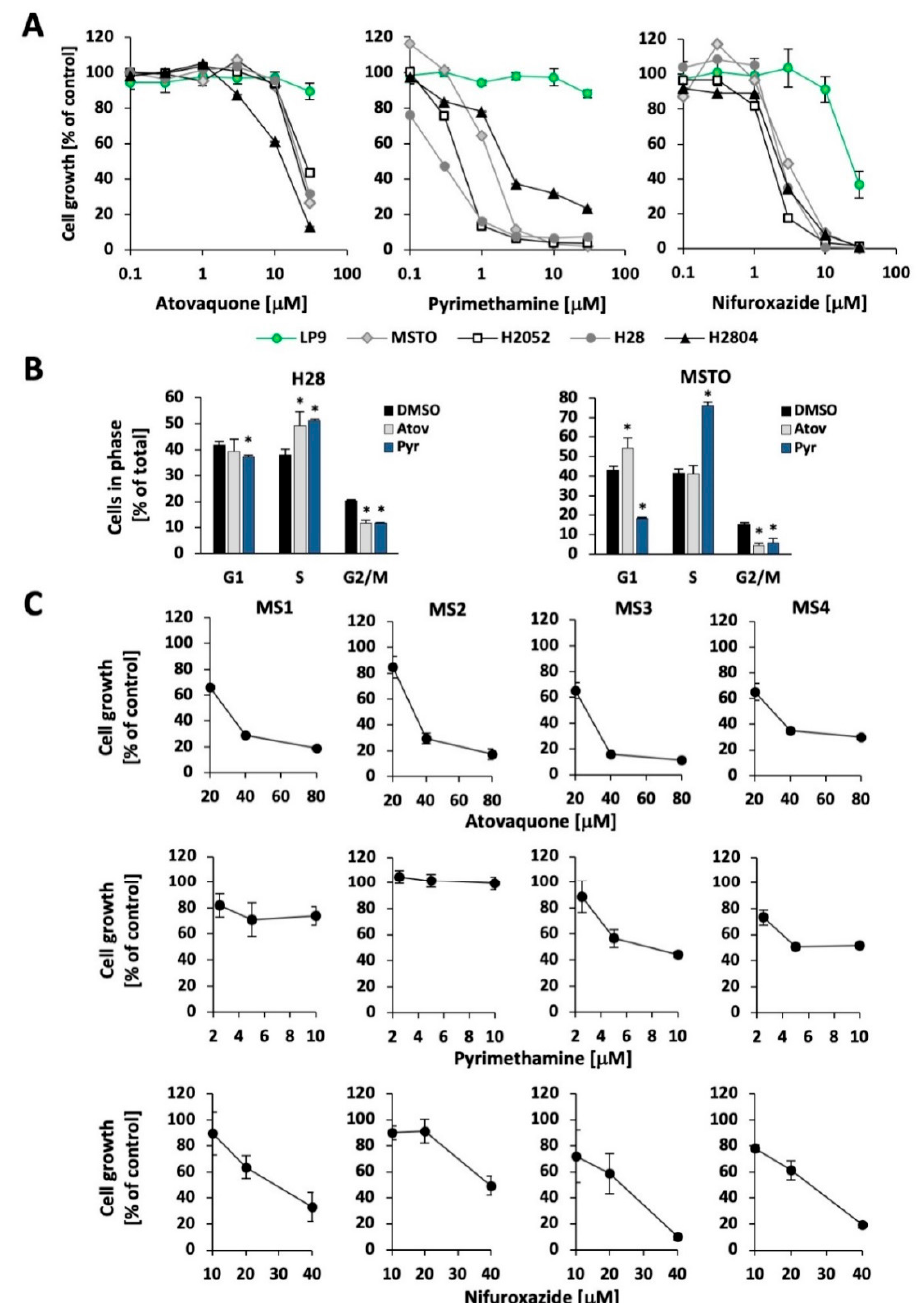
Figure 2. STAT3 pathway inhibitors reduce growth in MPM cell lines. ( A ) The MPM cell lines MSTO-211H (MSTO), H2052, H28, and H2804, as well as the nontransformed mesothelial cell line LP9, were treated with the indicated concentrations of atovaquone, pyrimethamine, or nifuroxazide for 72 h, after which viable cell number was quantitated ( n = 4). ( B ) Cell cycle distribution was determined by propidium iodide staining in H28 and MSTO-211H (MSTO) cells in response to 30 μ M atovaquone, 10 μ M pyrimethamine or vehicle (control) after 18 h of treatment ( n = 3) (* significant differences are indicated, p < 0.05). ( C ) MPM primary-derived cell lines (MS1-MS4) were treated with atovaquone, pyrimethamine, and nifuroxazide in a three-day assay ( n = 4), as indicated.